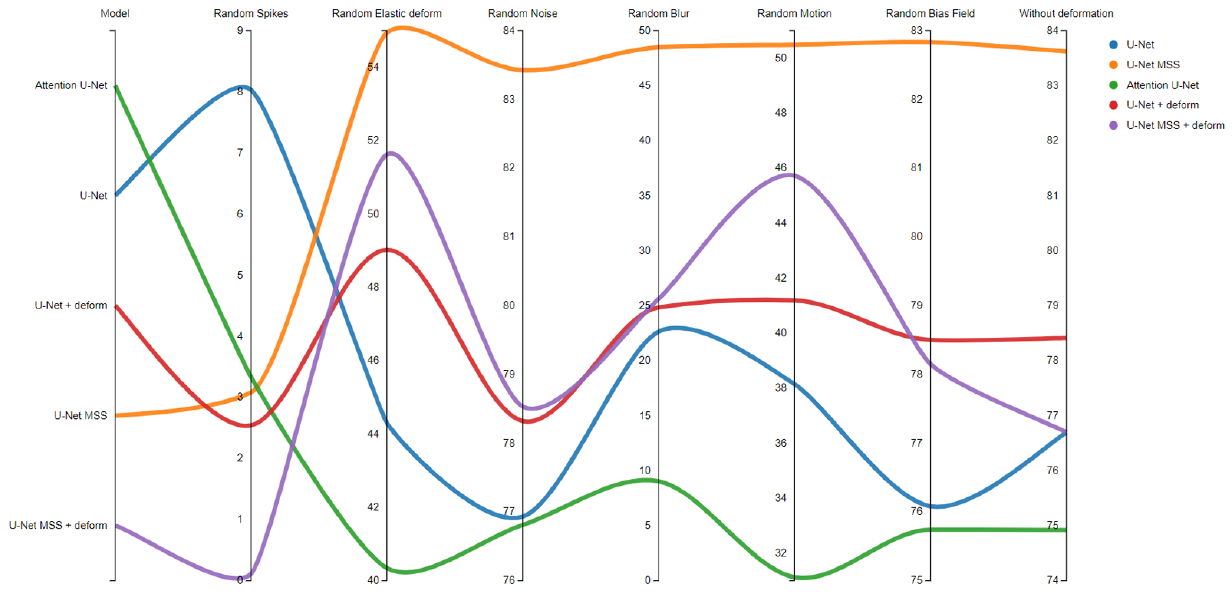
Figure A1. Resultant average Dice scores yielded by the different models after receiving input volumes having different types of MR